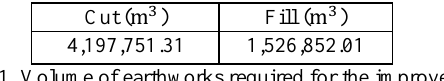
Table 11. Volume of earthworks required for the improvement Table 7. Approximate total cost of the improvement of the existing line on flat land Table 12. Total length of engineering structures required for the